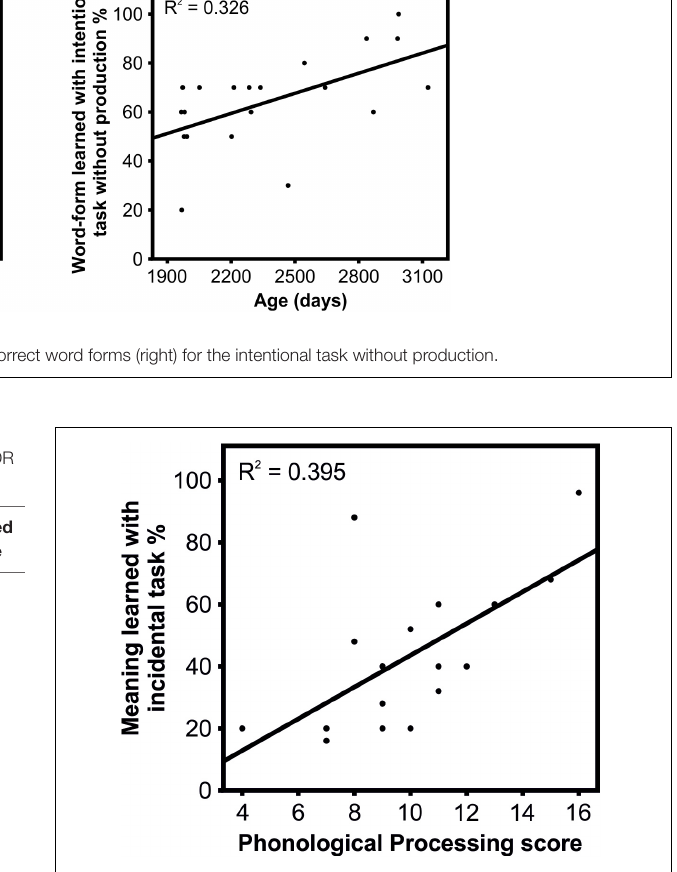
FIGURE 4 | Correlation between the Phonological Processing score and learning the meanings for the incidental